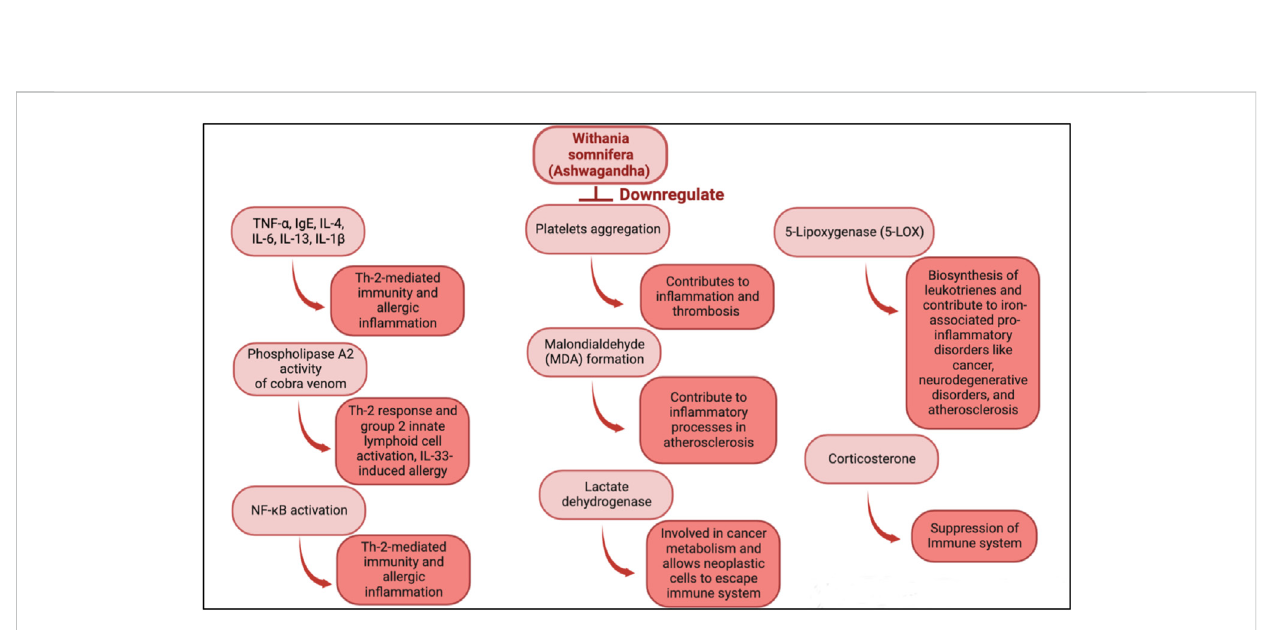
harmful immune responses (Figure 2, Figure 3). For instance, the therapeutic effects of w. Somnifera on robust Th2 immune responses and airway in fl ammation is very promising. When administered in mice, w. Somnifera upregulates Th1 immune responses accompanied by an increase in CD4 and CD8 T cells, thus, balancing the Th2-Th1 immune responses (Bani et